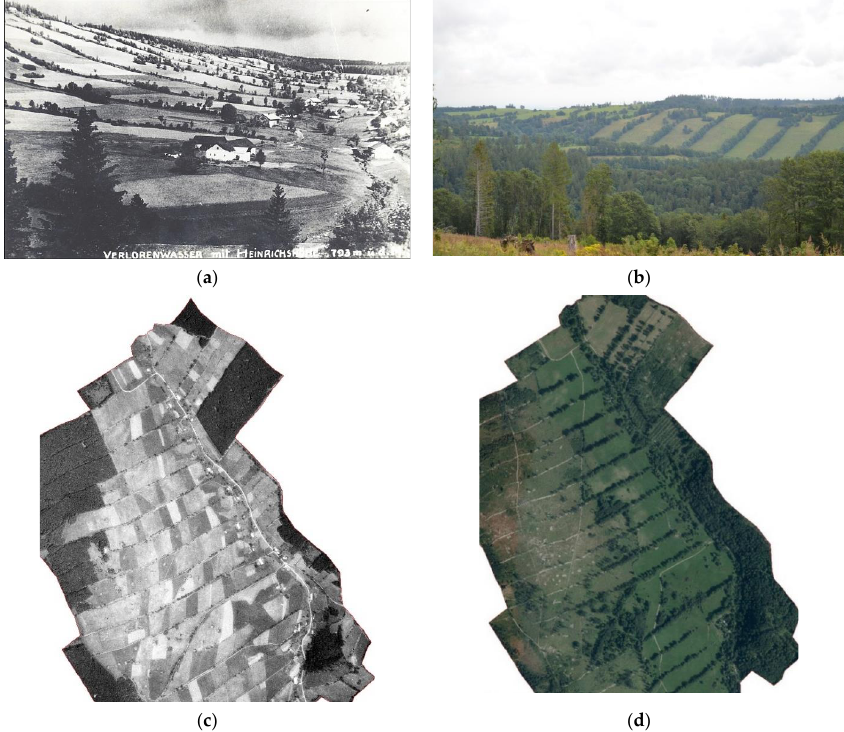
Figure 11. Preserved landscape texture (Ztracená Voda, 50.2030528N, 17.4801681E): ( a ) photo from the beginning of the 20th century; ( b ) actual photo (2020); ( c ) aerial survey image (1937); ( d ) aerial survey image (2020). Source: Ortofoto 2020 (© ČÚZK , www.cuzk.cz, accessed on 20 March 2020), image 1946 —VGHMÚř Dobruška, © Ministry of Defense of the CR.